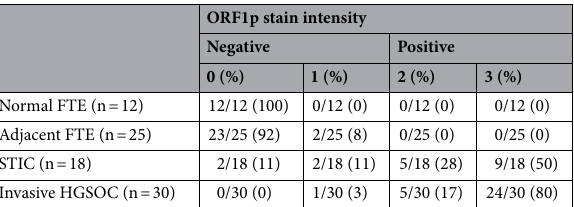
Table 1. ORF1p expression in serous tubal intraepithelial carcinoma and HGSOC. FTE Fallopian tube epithelium, STIC serous tubal intraepithelial carcinoma, HGSOC high-grade serous ovarian carcinoma.